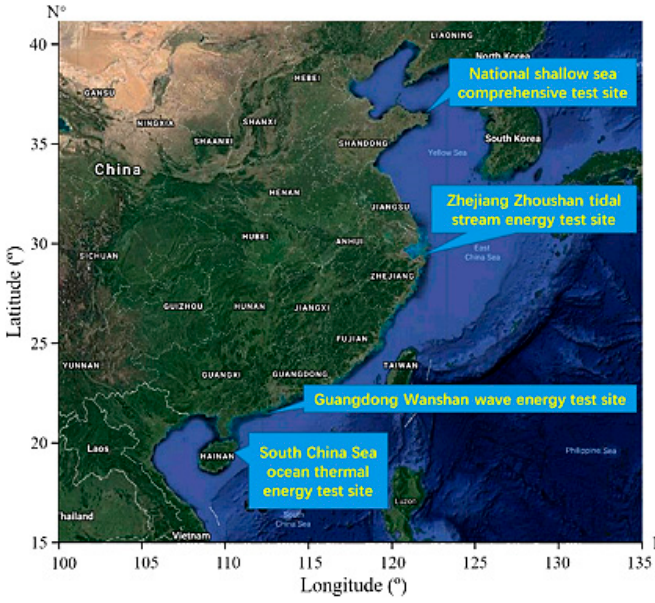
Figure 2. Ocean energy demonstration bases in China. Table 1. The Installed Capacity of Wave Energy Converter All Over the World